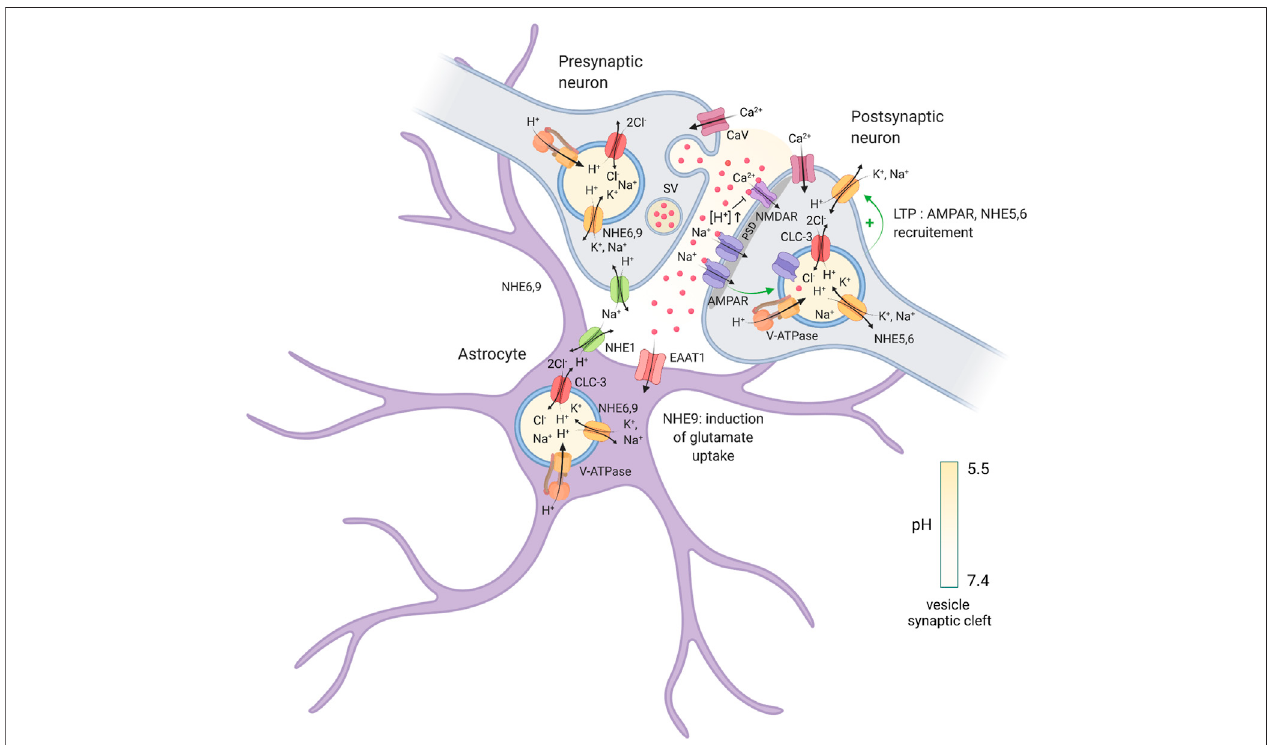
FIGURE 1 | Regulation of intracellular pH at a tripartite synapse. Illustration of a tripartite synapse (presynaptic axon terminal, postsynaptic dendritic spine and astrocyte) and localization of different proteins involved in cytosolic and endosomal pH regulation and neurotransmission. V-ATPase, vacuolar H + -ATPase; NHE, (Na + , K + )/H + exchangers; CLC-3, 2Cl − /H + exchanger isoform 3; CaV, voltage-gated calcium channel; EAAT1, excitatory amino acid transporter 1; NMDAR, N -methyl-D- aspartate receptor; AMPAR, α -amino-3-hydroxy-5-methyl-4-isoxazolepropionic acid receptor; PSD, postsynaptic density; SV, synaptic vesicle; red balls; glutamate. Created with